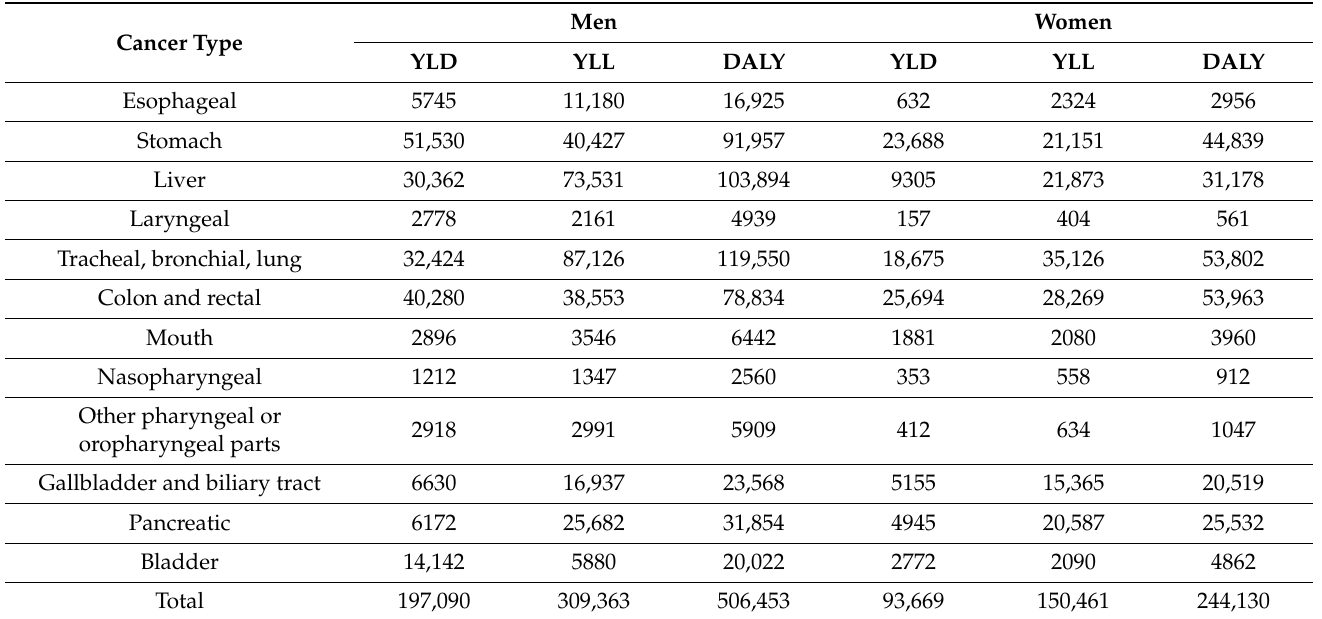
Table 1. DALYs associated with 12 cancers in Koreans aged ≥ 40 years (2018) (unit: person-years). Men Women Cancer Type YLD YLL DALY YLD YLL